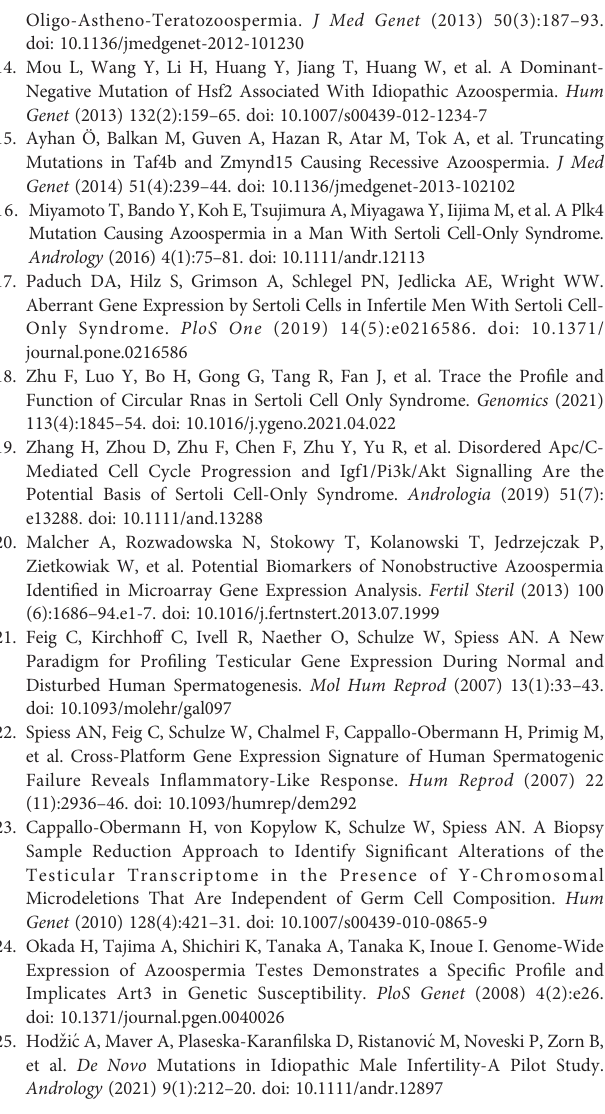
Supplementary Figure 4 | Hierarchical cluster analysis of samples in the OA and SCOS testicular tissue samples. OA, obstructive azoospermia; SCOS, Sertoli cell- only syndrome. Supplementary Figure 5 | After network topology analysis for soft-threshold powers, the scale-free topology b was selected as soft threshold power for (A) OA and (B) SCOS groups, respectively. OA, obstructive azoospermia; SCOS, Sertoli cell-only syndrome.